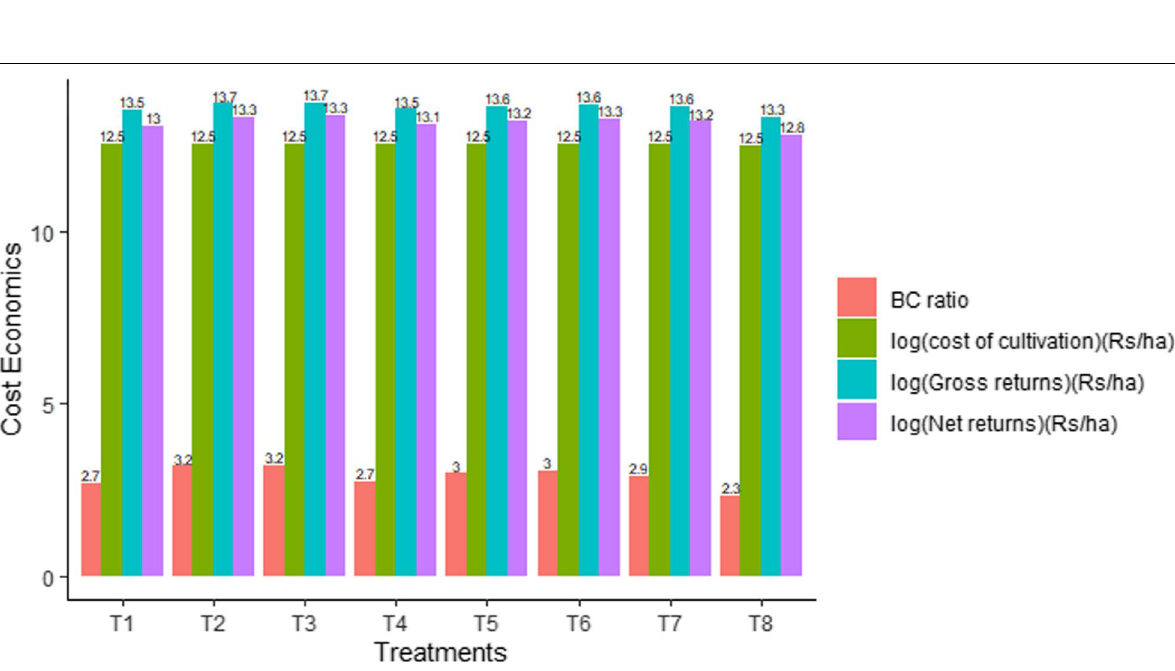
(Loper and Buyer 1991).